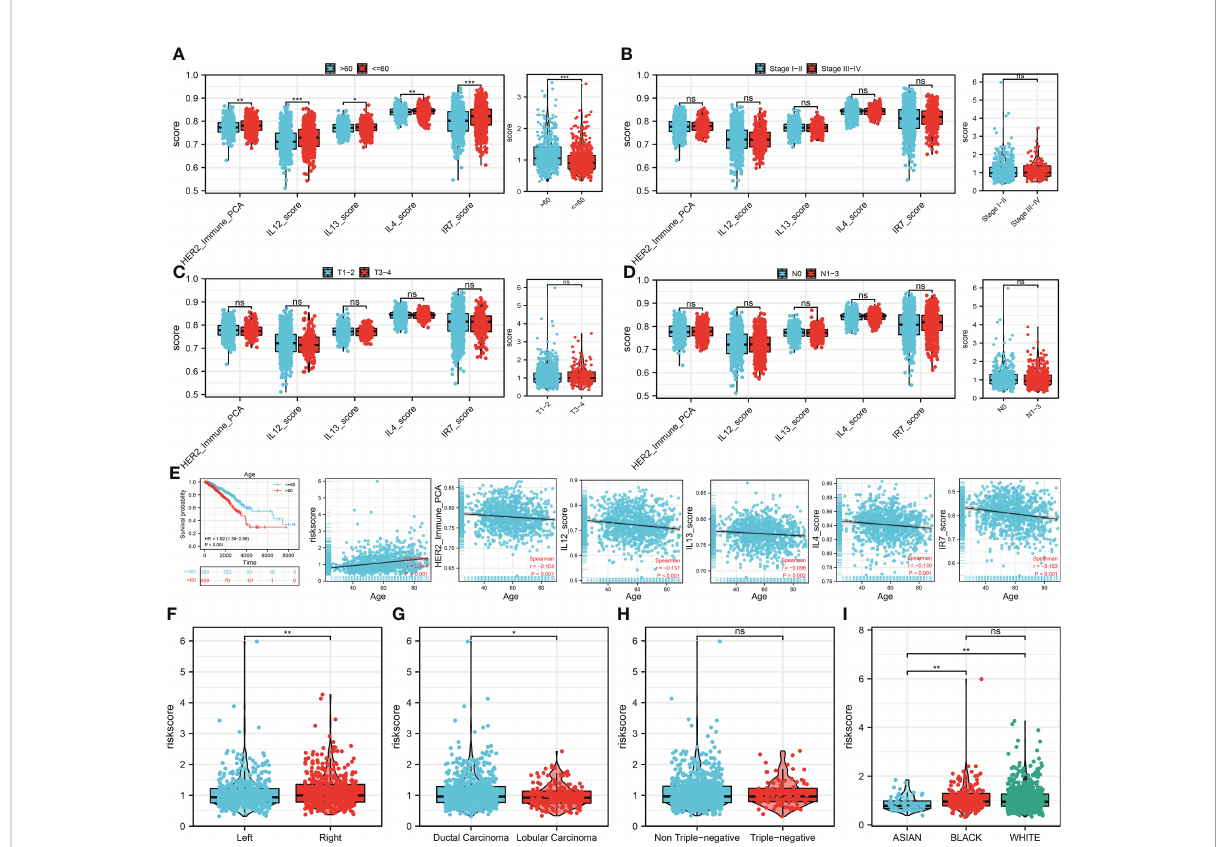
FIGURE 4 Clinical correlation analysis (A) The difference of model immune terms and riskscore in different age groups. (B) The difference of model immune terms and riskscore in different stage groups. (C) The difference of model immune terms and riskscore in different T stage groups. (D) The difference of model immune terms and riskscore in different N stage groups. (E) Elderly patients might have a worse prognosis compared with the younger patients. (F – I) The riskscore difference in different clinical groups. *P <0.05; **P < 0.01; ***P <